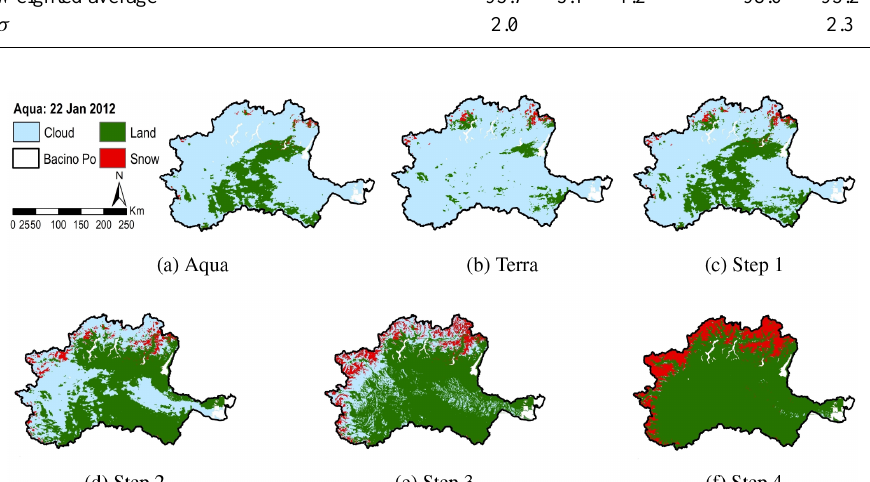
Figure 11. Cloud removal procedure applied to 22 January 2012. Aqua and Terra maps have a cloud coverage of 77 and 91%, respectively. The cloud removal is basically completed by step